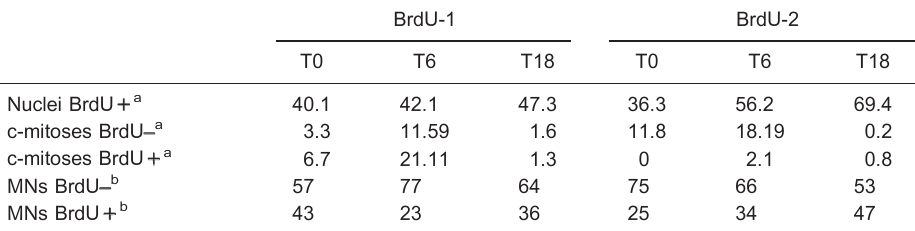
a Results are reported as percent of 1000 cells counted. b Results are reported as percent of 100 micronuclei counted. BrdU: 5-bromo-2-deoxyuridine; MNs: micronuclei; FCS: fetal calf serum; T: times of recovery after vincristine removal (0, 6, and 18